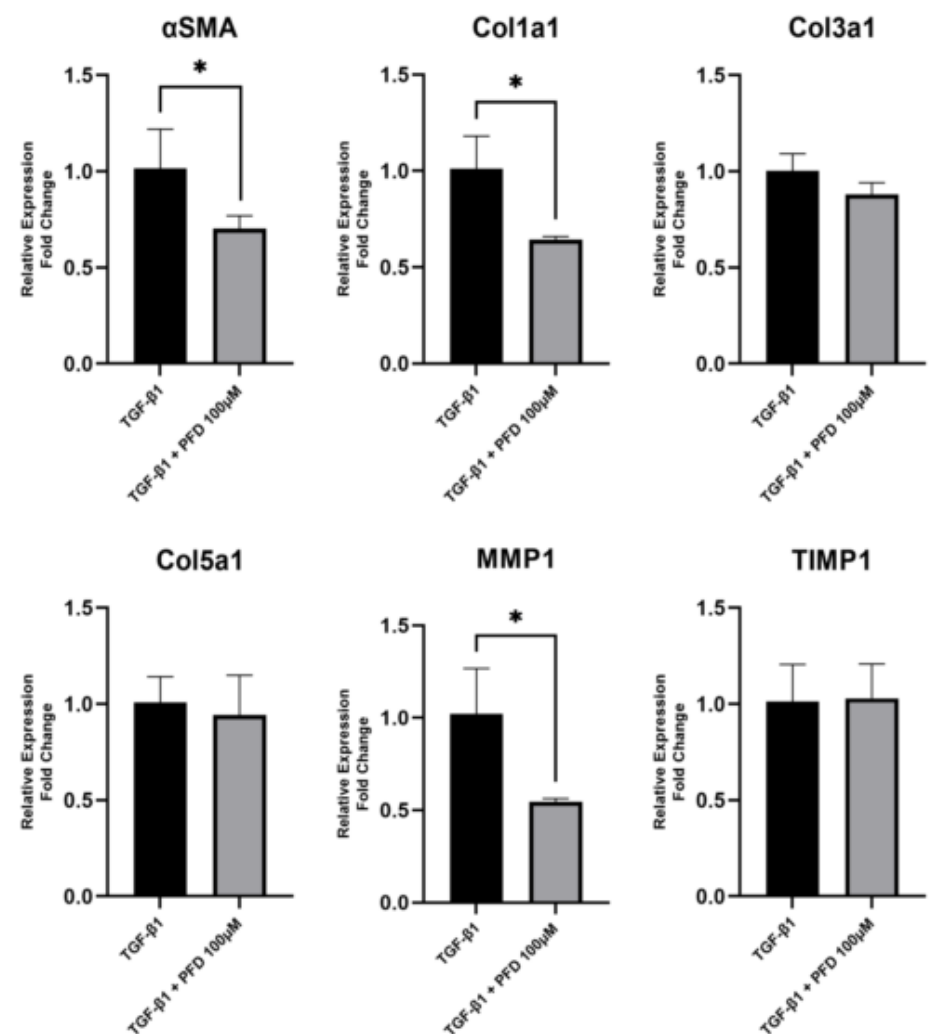
Figure 2. Gene expression of fibrosis-related genes in primary HCF cell culture in response to treatment with TGF- β and pirfenidone. HCF cell were stimulated with TGF- β for 24 h in the presence or absence of PFD at 100 µ M. Gene expression was measured by RT-PCR. PFD at 100 µ M reduced α SMA, MMP1 and Col1a1 mRNA expression. Data represented as mean ± standard deviation. HCF, human corneal fibroblast; TGF- β , transforming growth factor- β ; PFD, pirfenidone; TIMP1, tissue inhibitor matrix metalloproteinase 1; α SMA, α smooth muscle actin; Col1A1, collagen 1A1; Cola3A1, collagen 3A1; Col5A1, collagen 5A1; MMP1, matrix metalloproteinase 1; RT-PCR, real time polymerase chain reaction. * p < 0.05 vs. TGF- β1 group.